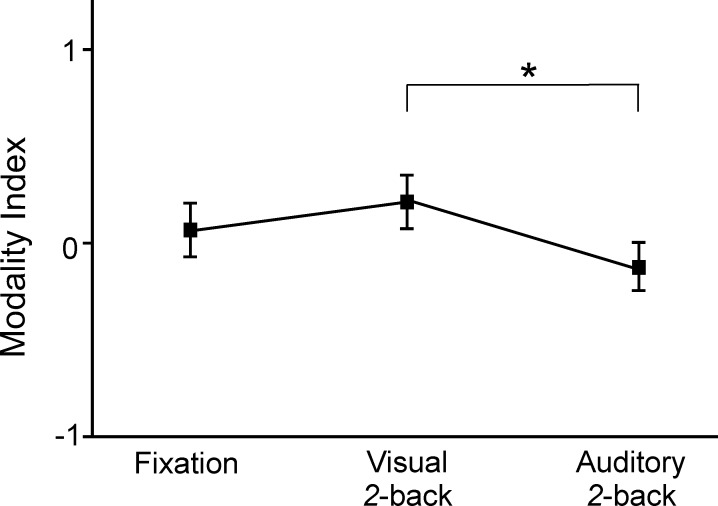
Observed relations between task modality and form of mind wandering.Modality index of -1 indicating mind wandering being always auditory and 1 being always visual. Error bars represent ±1SE. Observation indicated mind wandering is greater in the same modality as the concurrent task.